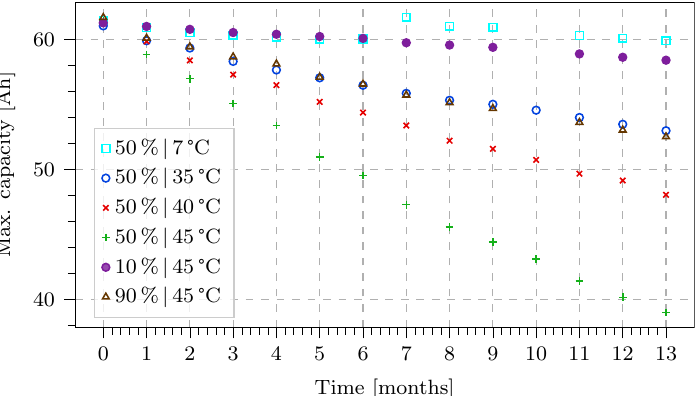
Figure 4. Capacity degradation for different storage conditions. Measurements taken at 25 °C. In the legend, the leftmost column represents the storage SoC, and the rightmost one, the storage temperature.